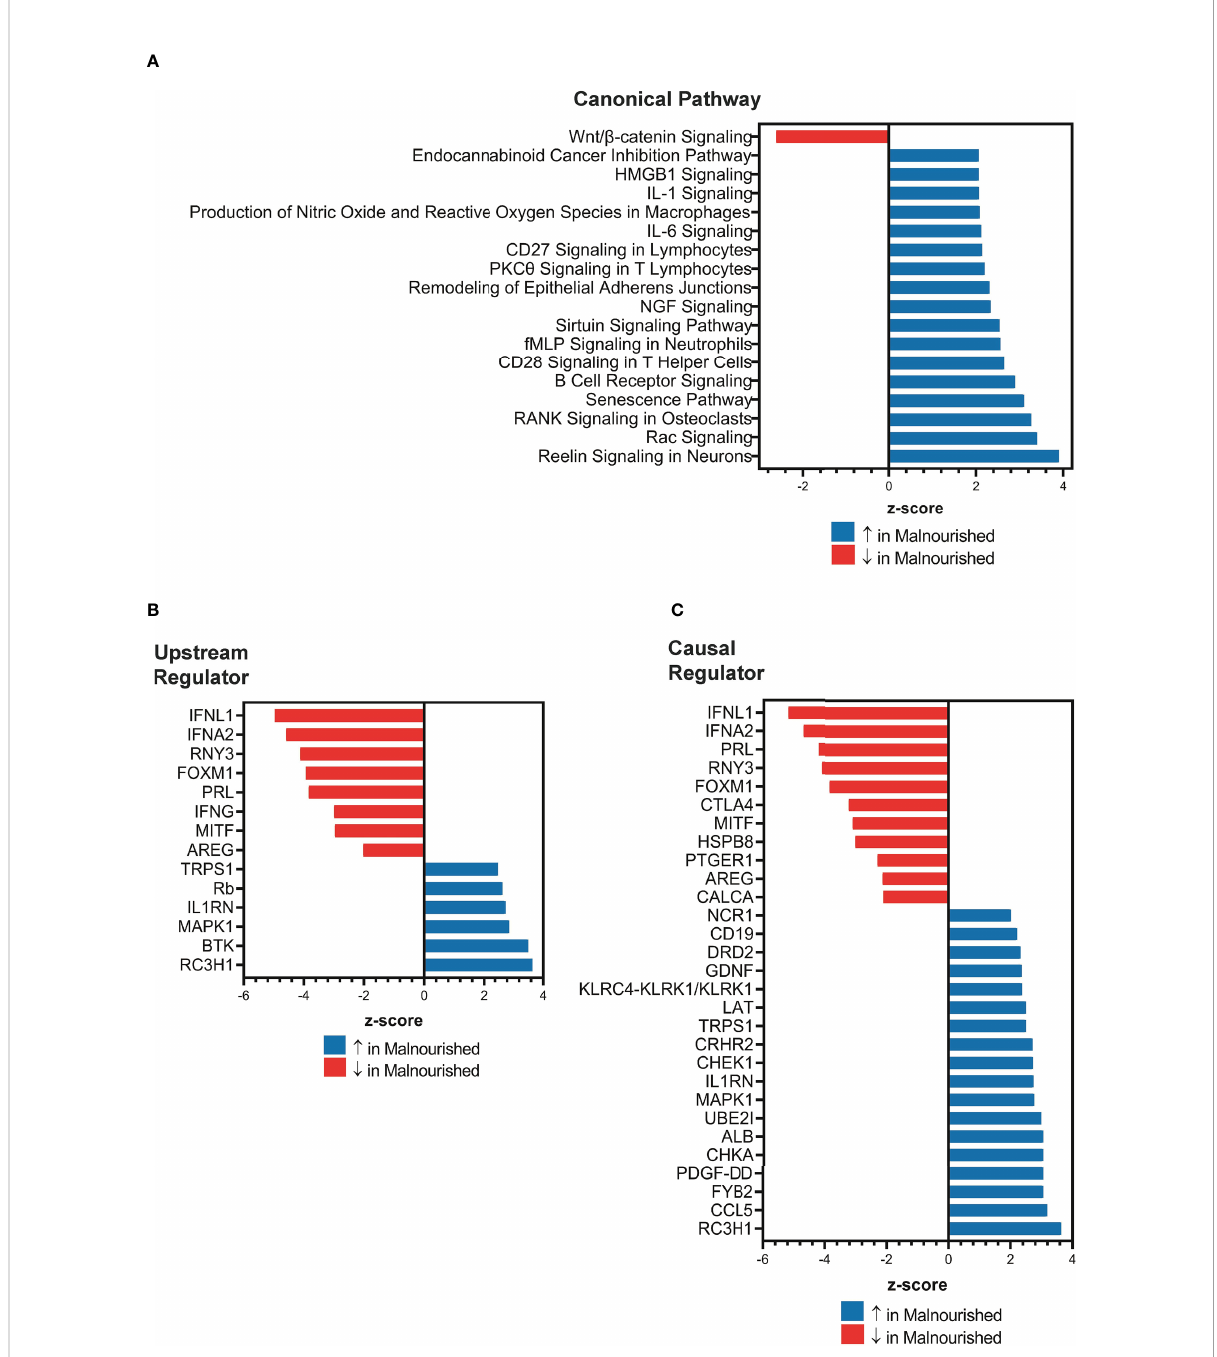
FIGURE 2 Increased in fl ammation and immune regulation pathways in malnourished individuals with latent TB infection. IPA of DEGs among malnourished individuals and control individuals showing top canonical pathways [p < 0.01; (A) ], upstream regulators [p < 0.001; (B) ], and causal regulators (p < 0.001; (C) ). Pathways and regulators in blue represent upregulation and those in red represent downregulation in malnourished